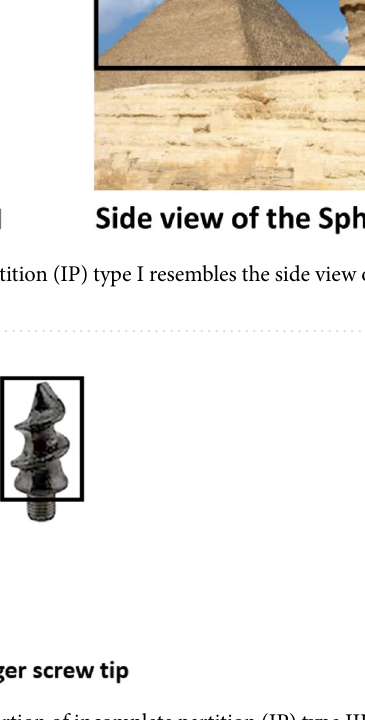
Figure 7. Mid-modiolar section of the cochlear portion of incomplete partition (IP) type III resembles an Auger screw tip. The width of the inner auditory canal (IAC) is as wide as the cochlear basal turn. Images are not to